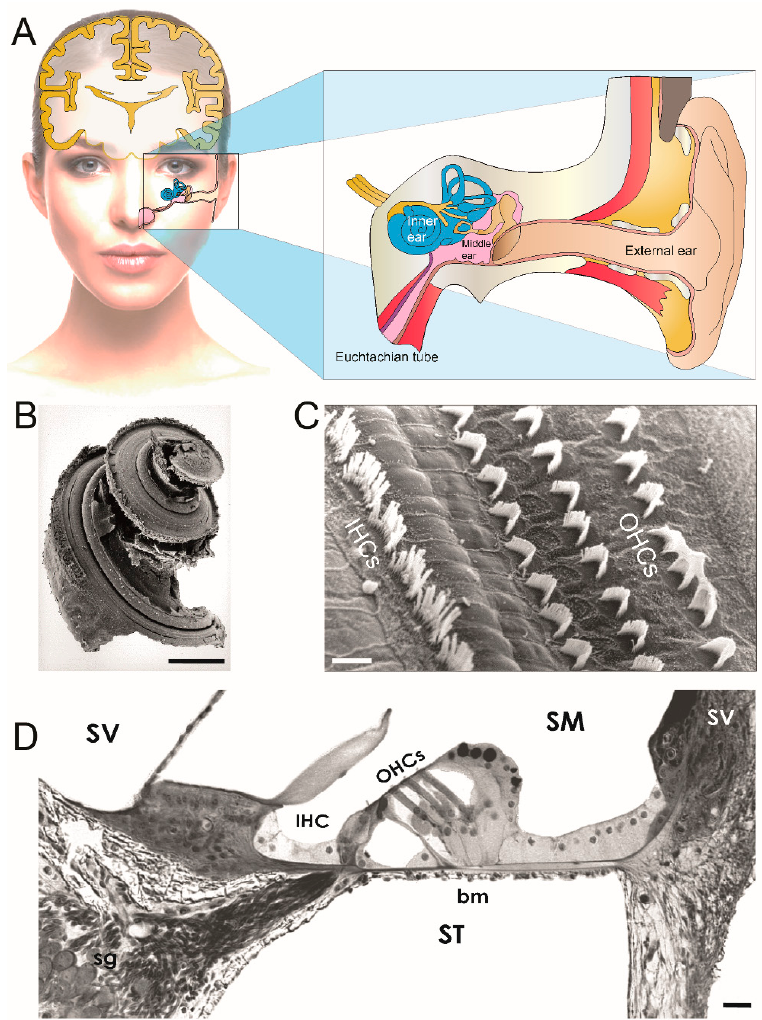
Figure 1. Inner-ear anatomy. ( A ) Schematic representation of ear anatomy. The ear is divided into three parts (insert): the external and middle ear transfer the sound waves to the inner ear where they are transduced into neural activity. The external ear is closed off from the middle ear by the eardrum. In the middle ear, the eardrum is mechanically linked, by a chain of three tiny bones (the ossicles), to the oval-window membrane which closes the inner ear. Embedded in the temporal bone, the inner ear comprises the balance organ or vestibule, and the hearing organ or cochlea. ( B ) Scanning electron micrograph of the organ of Corti. The cochlea is a coiled organ that forms a spiral. Scanning electron micrographs show a narrow, linear shape of IHC stereocilial bundles and a V-shape of OHC stereocilia. ( C ) Transverse section of the basal cochlear turn under light microscopy. The cochlea is made up of three canals wrapped around a bony axis, the modiolus. These canals are the scala tympani (ST), the scala vestibuli (SV), and the scala media (SM). The ST and SV are filled with perilymph. The SM is filled with endolymph. The organ of Corti is situated on the basilar membrane (bm). ( B ) = 2 mm, ( C ) = 10 µM, ( D ) = 50 µm. IHCs: inner hair cells; OHCs: outer hair cells (( B – D ) micrographs courtesy of Marc Lenoir, Inserm U1051, France).